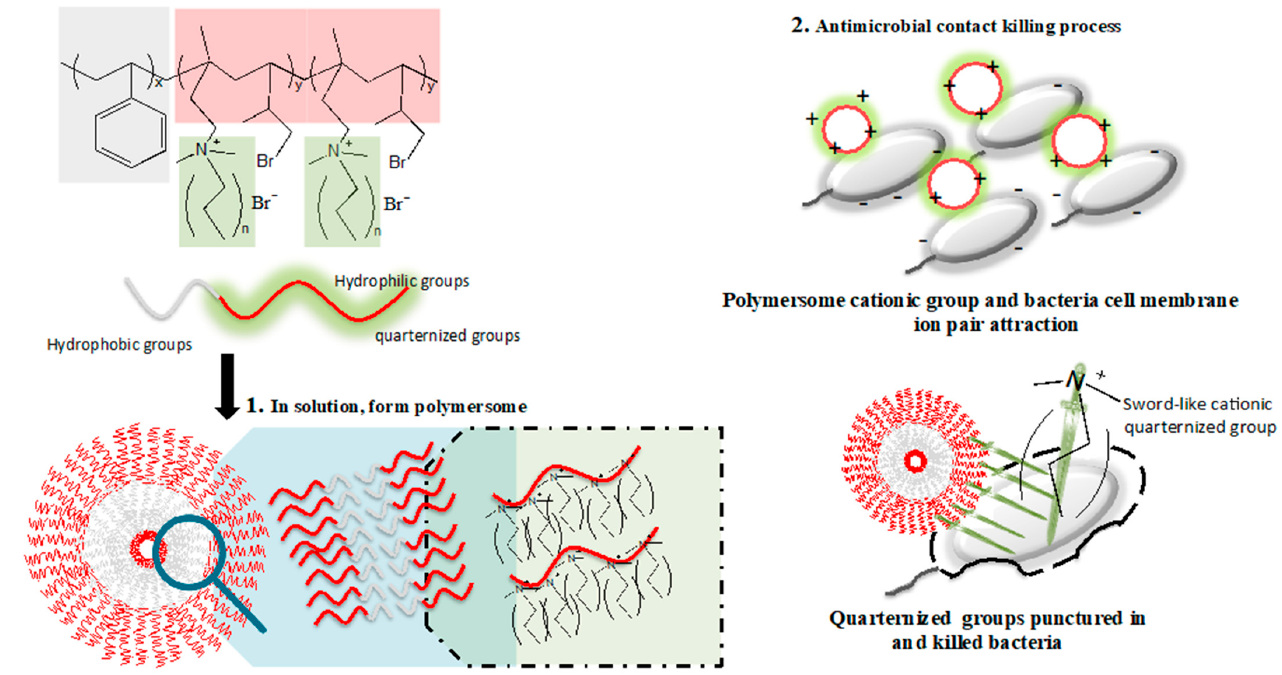
Figure 8. Schematic of proposed quaternized amphiphilic block copolymers PS- b -PIN polymersome formation and antibacterial activities.